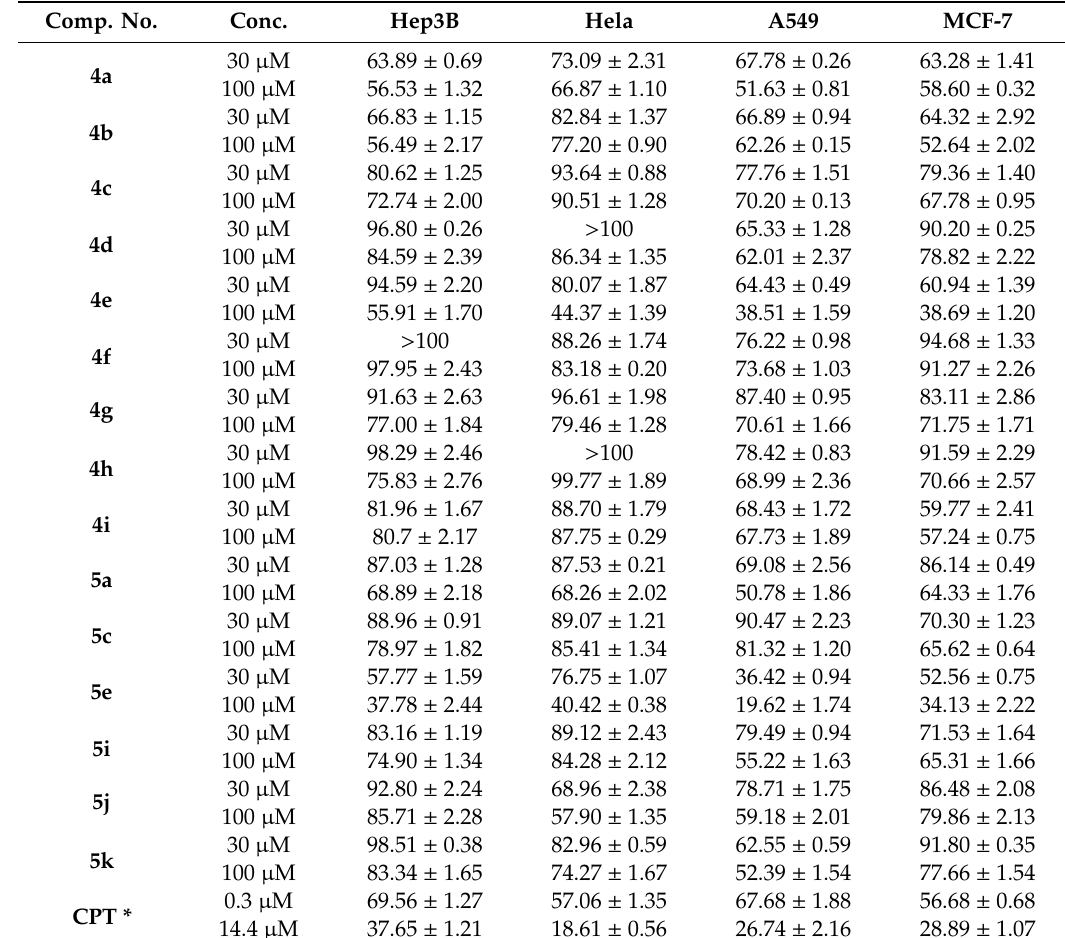
Table 4. The e ff ect of newly synthesized hydrazide-hydrazone 4a – i and 5a – k on the viability of HeP3B, Hela, A549, and MCF-7 cells after 48 h of incubation. Comp.